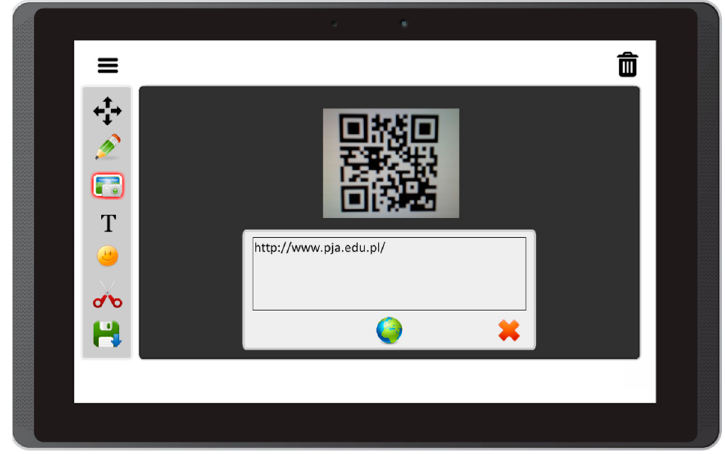
Figure 6. Reading QR codes for opening websites in Aphasia Create (screenshot from an Android tablet).